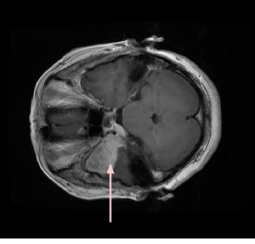
Figure 1. T1 Contrast-Enhanced MRI (CE-MRI) image depicting meningioma brain tumor (marked by